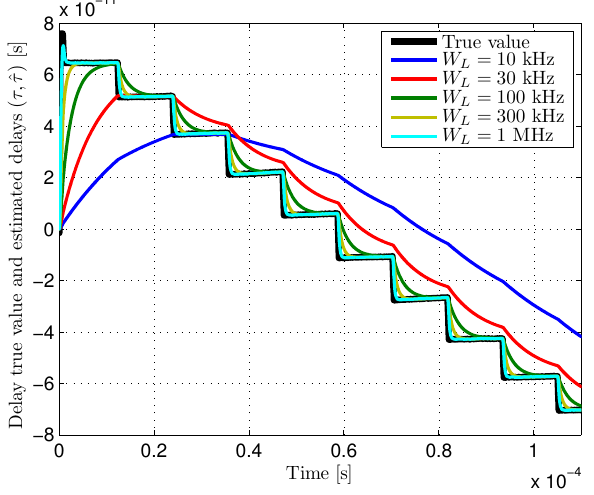
Figure 12. Delay true value ( τ ) and measured delays (ˆ τ ) with different loop bandwidths ( W ) for a delay rate of change ( ∆ L HW limitations) ≈ 18